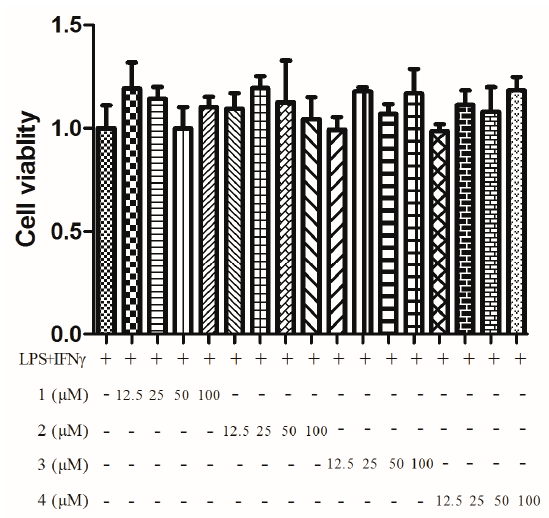
Figure 7. Cell viability determined by MTT assay. The experiment was performed four times, and the data are expressed as mean ± S.D. values.